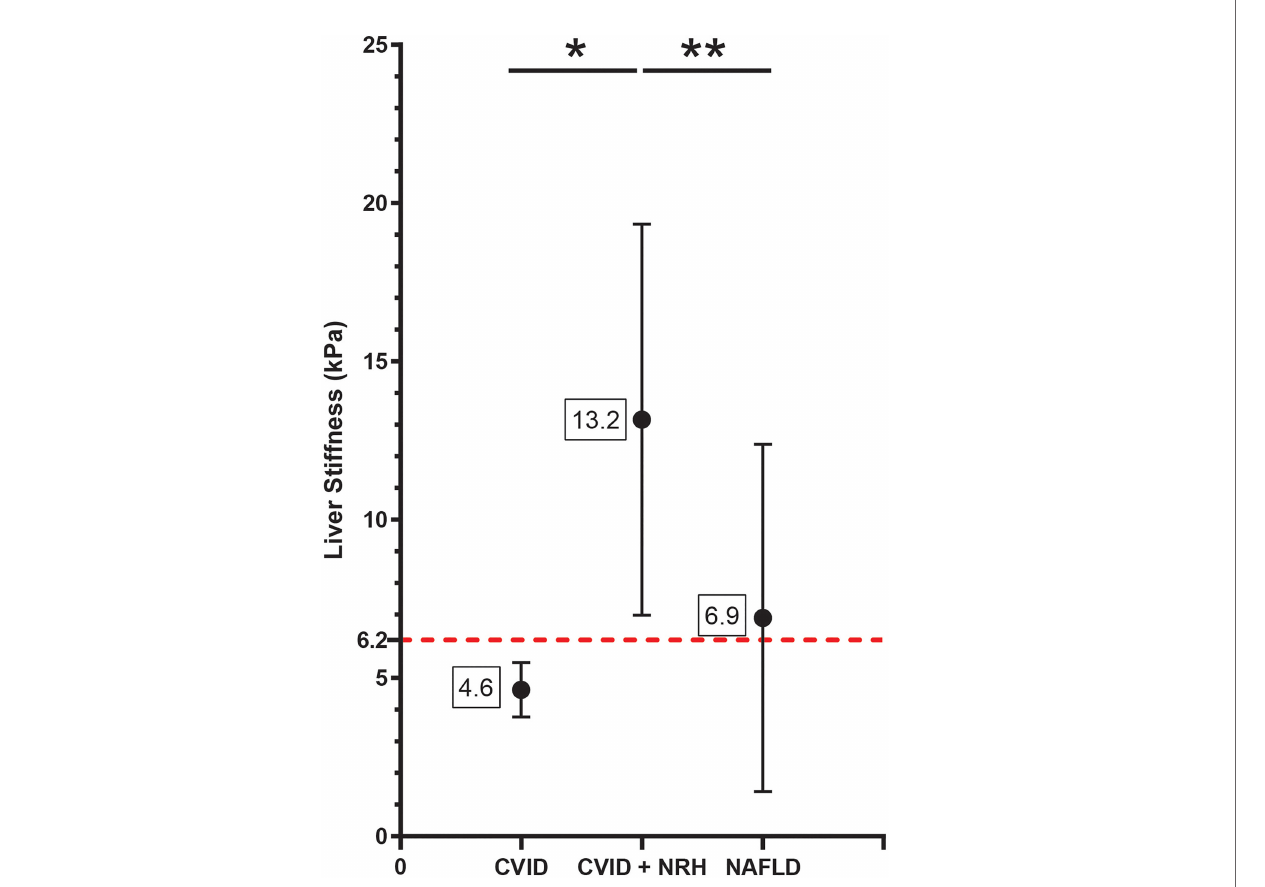
FIGURE 1 | Liver stiffness by transient elastography is signi fi cantly elevated in CVID patients with NRH. Liver stiffness measurements (kPa) by transient elastography shown as mean (± SD) in CVID patients with biopsy-proven NRH (CVID + NRH, N = 12), CVID patients without NRH (CVID, N = 6), and non-CVID patients with non- alcoholic fatty liver disease (NAFLD, N = 527). Signi fi cance by one-way ANOVA with Tukey ’ s post-hoc correction; *, p = 0.01; **, p < 0.01. Red dotted line indicates a diagnostic cutoff value for liver stiffness of 6.2 kPa (de fi ned using the ROC curve in Figure 4 ). CVID, common variable immunode fi ciency; NRH, nodular regenerative hyperplasia; ROC, receiver operating